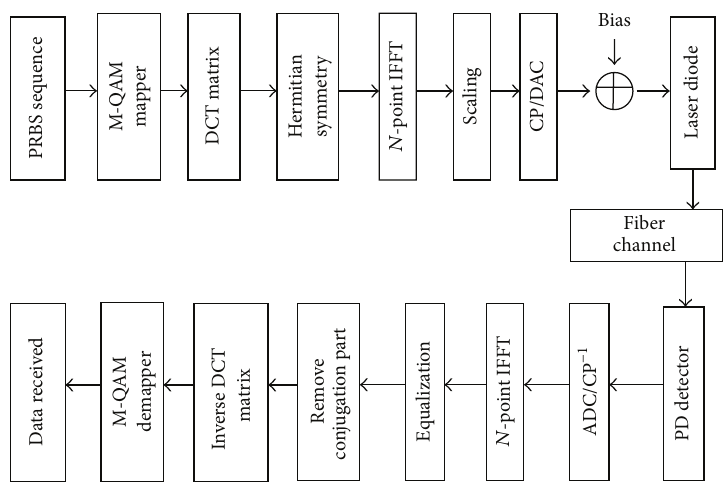
Figure 1: Conceptual diagram for a DCT precoded IM/DD optical OFDM system with